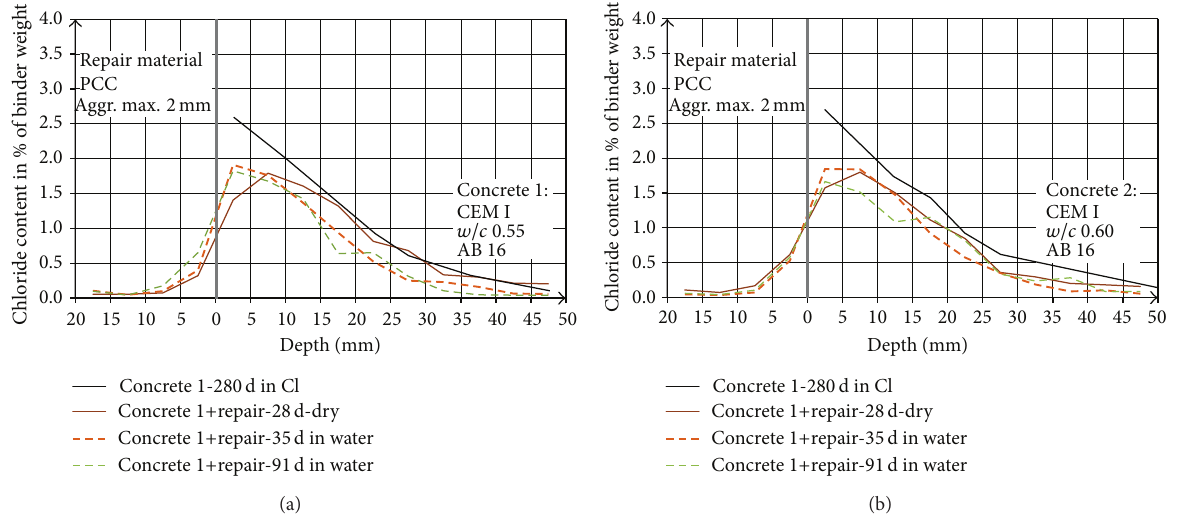
Figure 12: Chloride profiles of test series 2 (storage Cl-water); (a) concrete 1 with 𝑤/𝑐 = 0.55 ; (b) concrete 2 with 𝑤/𝑐 = 0.60